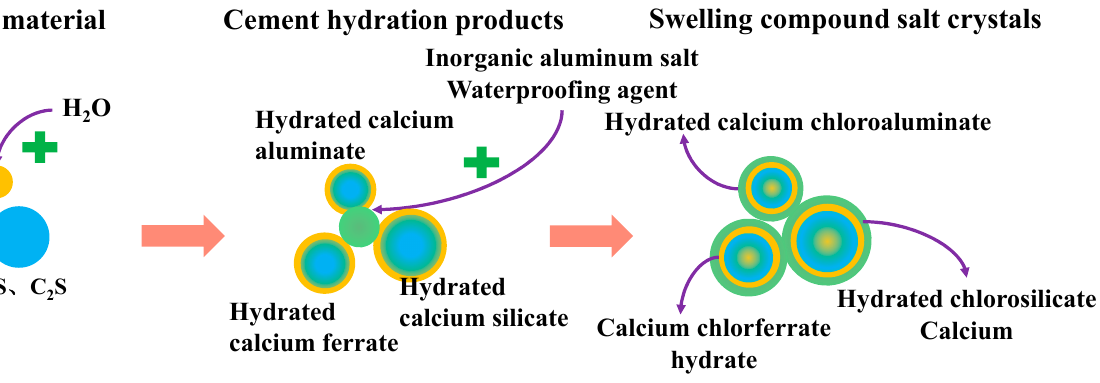
Figure 12. Inorganic aluminum salt waterproofing agent role model.